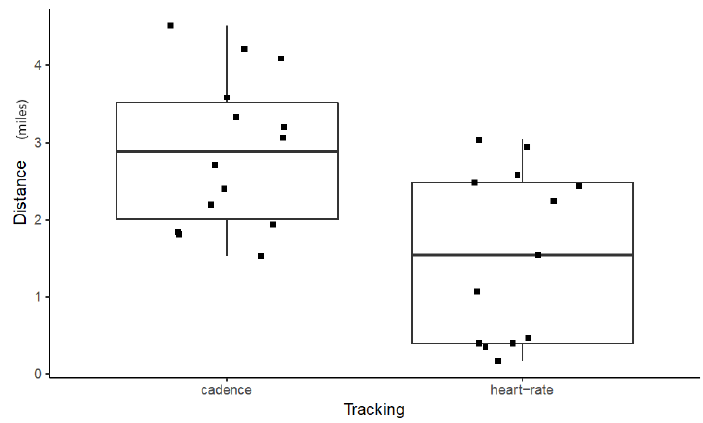
Figure 5. Boxplot for Distance completed (in miles) for Males by Tracking type.